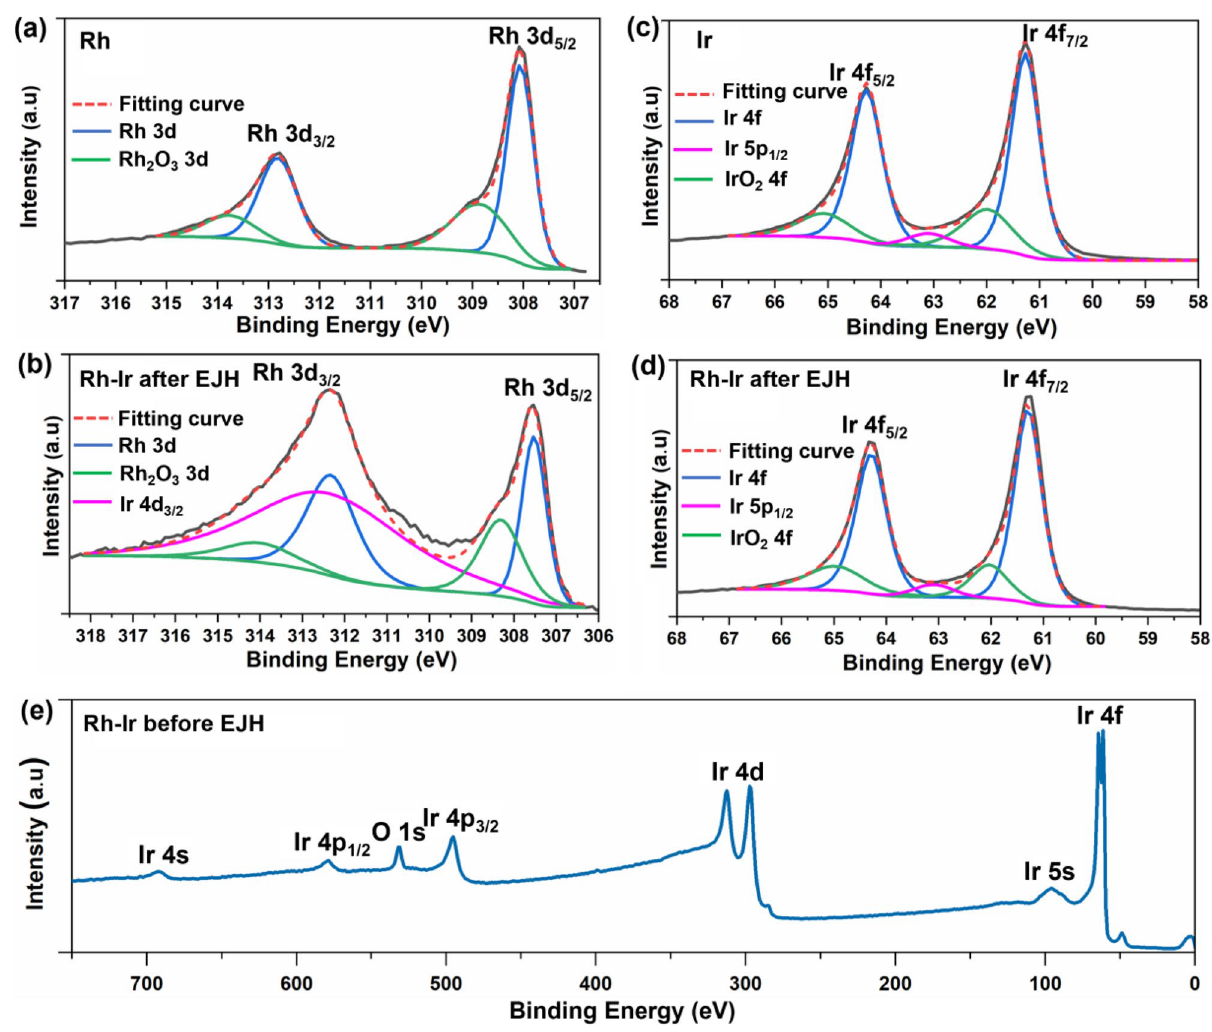
Figure 7. Rh 3d XPS spectra of ( a ) pure Rh and ( b ) Rh–Ir after EJH. Ir 4f XPS spectra of ( c ) pure Ir and ( d ) Rh–Ir after EJH. ( e ) XPS survey spectra of Rh–Ir thin film before EJH.